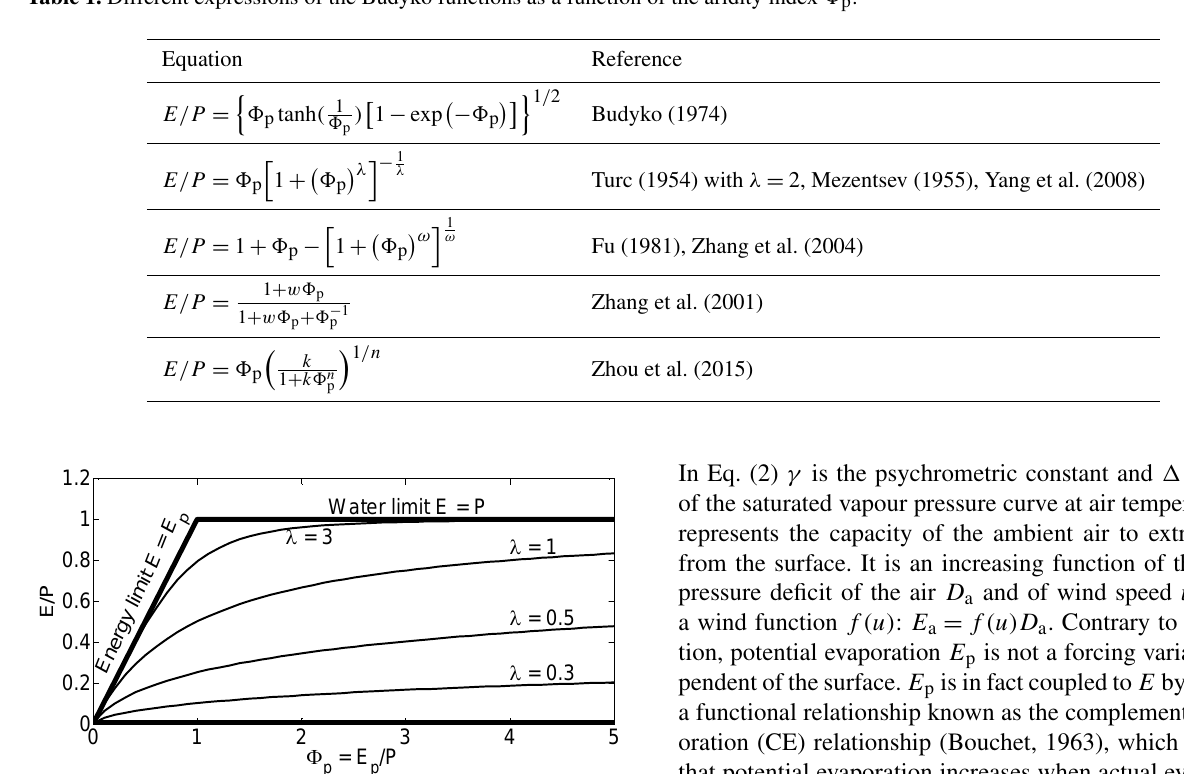
Figure 1. The Turc–Mezentsev relationship Eq. (4) between the ra- tio E/P and the aridity index (cid:56) p = E p /P for four values of the parameter λ (0.3, 0.5, 1 and 3). The bold lines indicate the upper and lower limits of the feasible